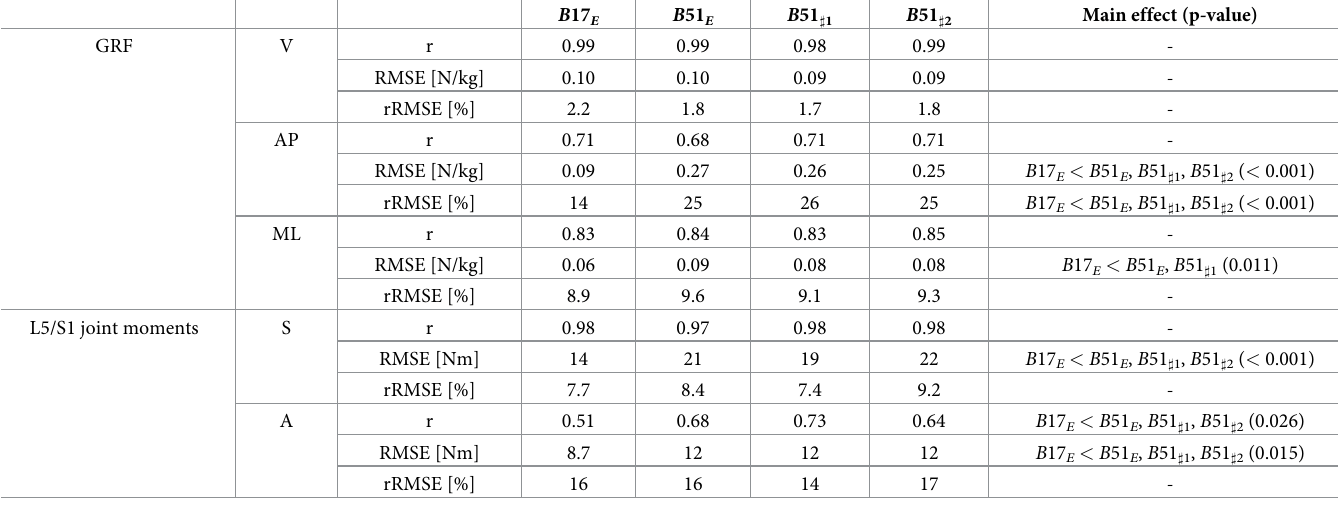
Tables 2 and 3 show the comparison measures for the three prediction methods and the four box configurations, respectively. Statistical significance (main and interaction effects) is described in the S1 File.